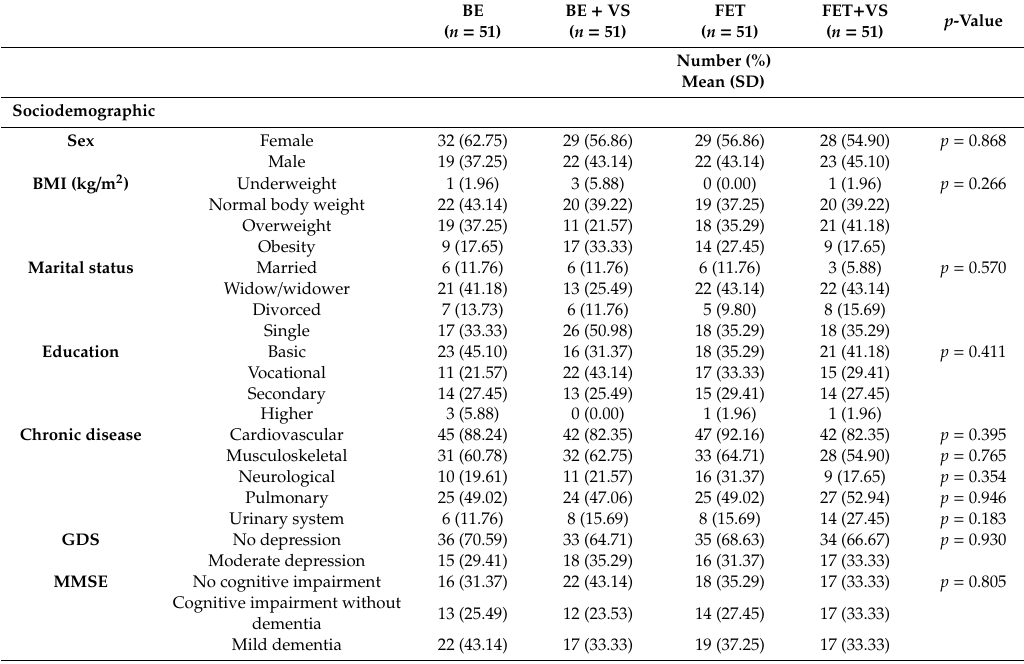
Table 1. Sociodemographic and clinical characteristics of the participants .